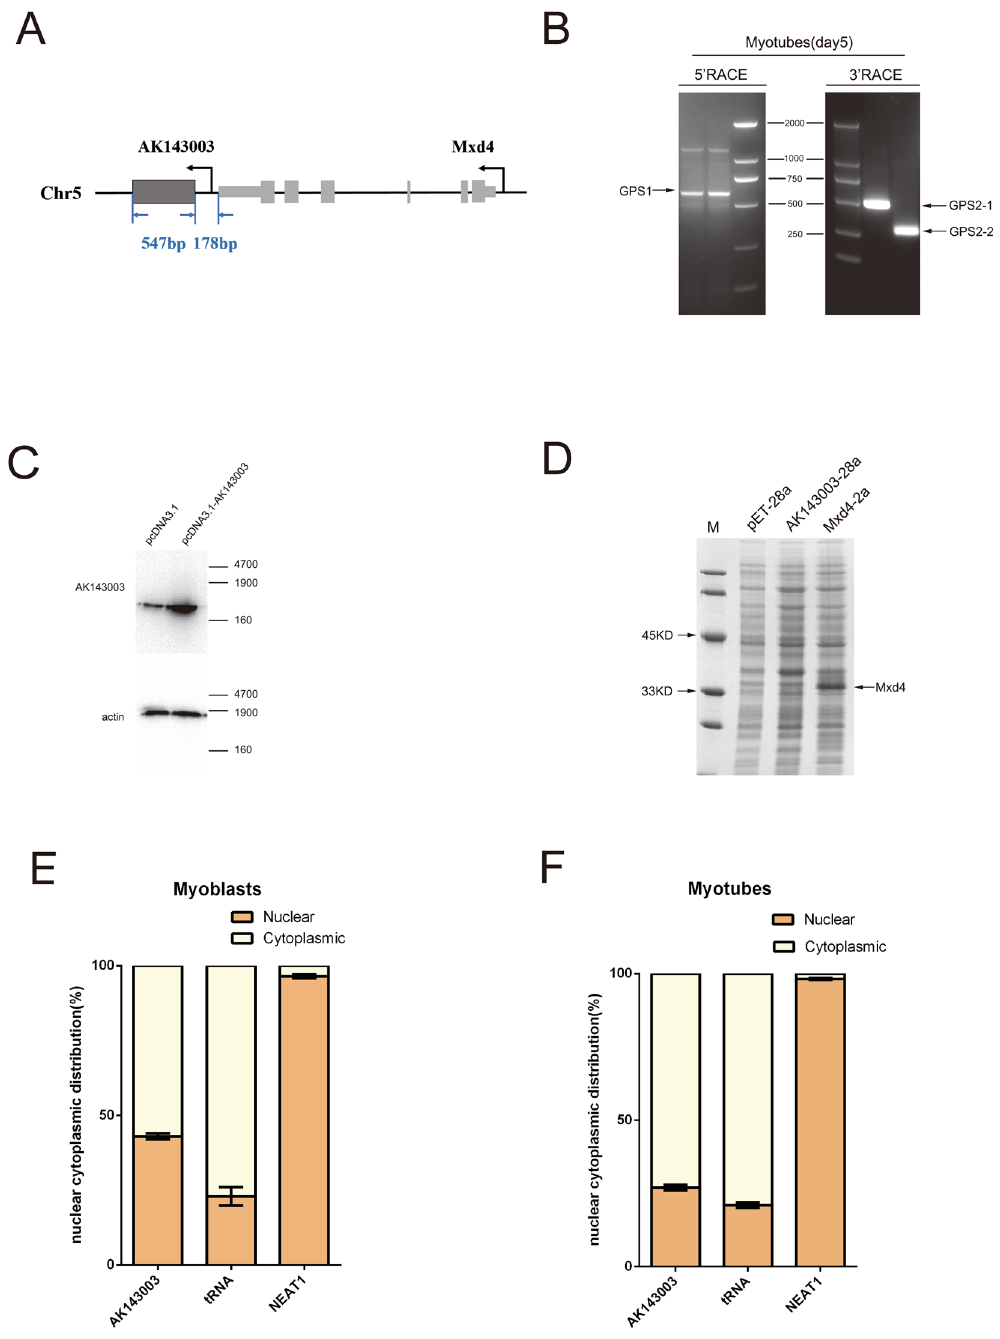
Figure 3. The characteristics of AK143003. ( A ) A sketch about the DNA sequence structure of AK143003. ( B ) Agarose gelelectrophoresis showing the 5 ′ and 3 ′ RACE results of AK143003 for 5 days differentiation. ( C ) Northern blot analysis of AK143003, which was extracted from 3 days differentiation of C2C12 cells after transfected pcDNA3.1-AK143003 or control vector. Actin was used as a loading control. ( D ) In vitro translation system showing no evidence of protein product with AK143003, while Mxd4 was proved as a coding protein. Actin was the positive control of the experiment. ( E and F ) RNA of C2C12 cells were fractionated into nuclei and cytosol fractions. AK143003 subcellular distribution were calculated by qPCR assay data, the graphs showed the expression in proliferative cells ( E ) and differentiated cells of 3 days ( F ), Cytoplasmic control ( tRNA ) and nuclear control ( NEAT1 ) were examined in their expected